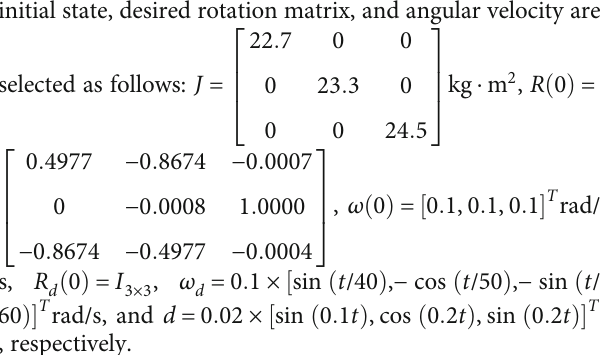
Figure 8: Control torque using the fi nite-time controller.